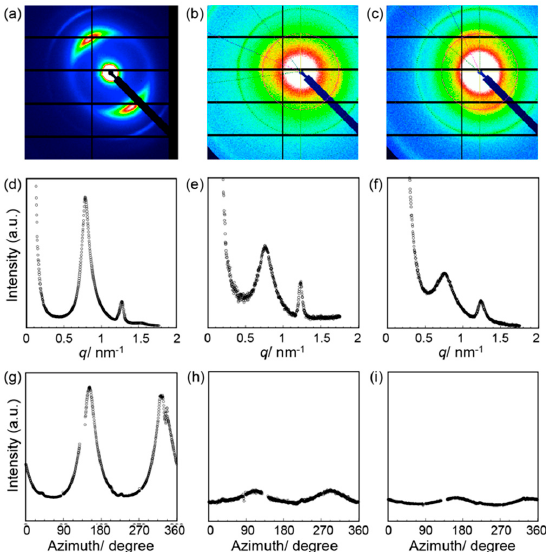
Figure 5. Small angle X-ray scattering analyses of the thermally treated M13 phage films. Two-dimensional (2D) patterns for the ( a ) outside, ( b ) midpoint, and ( c ) center of the film. The scattering curves for the ( d ) outside, ( e ) midpoint, and ( f ) center of the film. Azimuth scan of the primary peaks for the ( g ) outside, ( h ) midpoint, and ( i ) center of the film. Azimuth is zero in the upper direction from the center and increases in a clockwise direction in the 2D small angle X-ray scattering (SAXS) images.